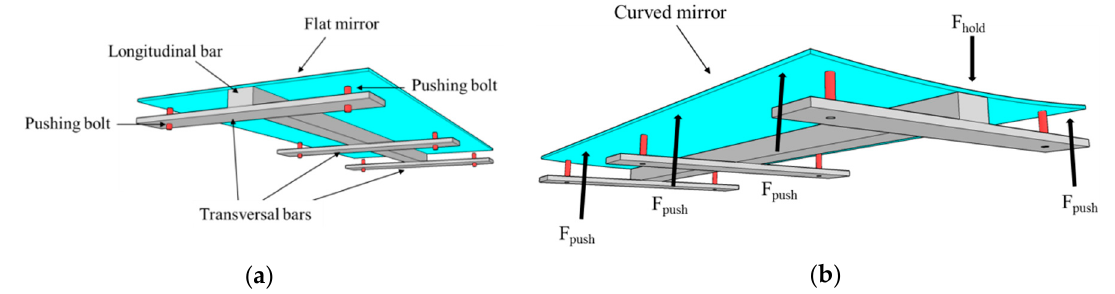
Figure 5. Scheme of the assembly for naked mirror mechanically bended by metallic bars glued to it: ( a ) mirror before being pushed by bolts and ( b ) mirror after being pushed by bolts.